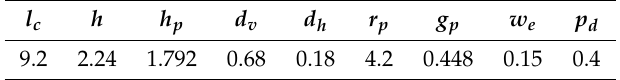
Table 1. Layout Dimensions of the Designed CSIW Resonator (Unit: